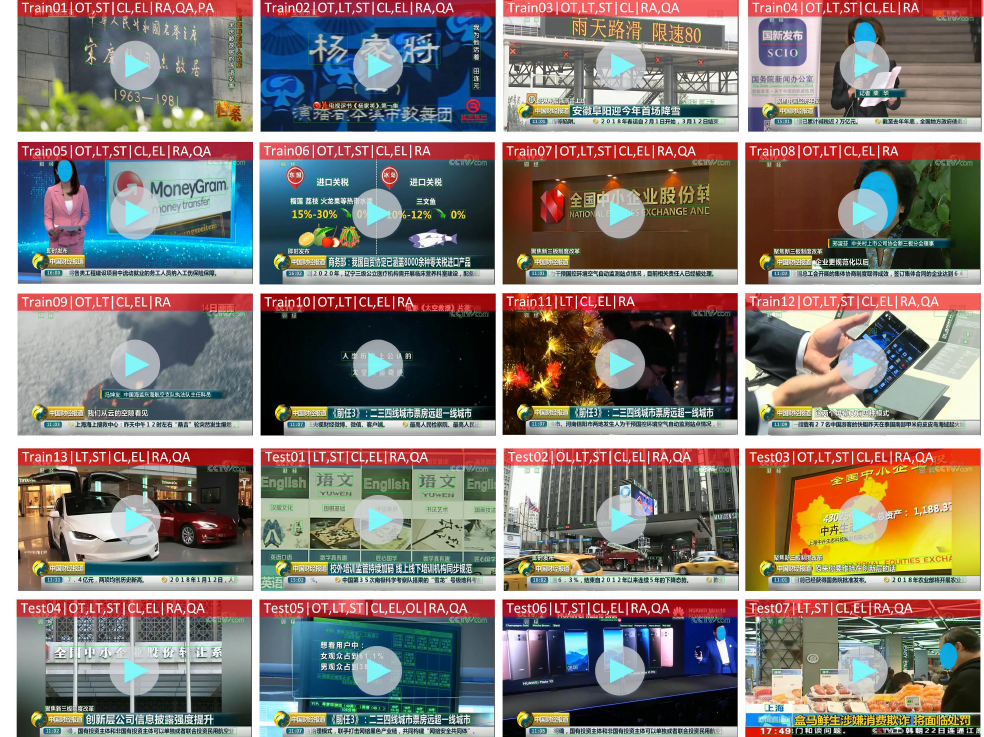
Figure 2. Illustrations of our Text3C dataset, which includes 13 training videos and 7 test videos. Text types are labeled as overlaid text (OT), layered text (LT), or scene text (ST). Text languages include Chinese (CT), English (ET), and Other (OT). Text instances can be framed in a rectangular box (RB), quadrilateral box (QB), or polygonal box (PB). The red bar at the top of each image denotes the video category, text type, text language, and text box, ( category | type | language | box ). Best viewed in color and zoomed